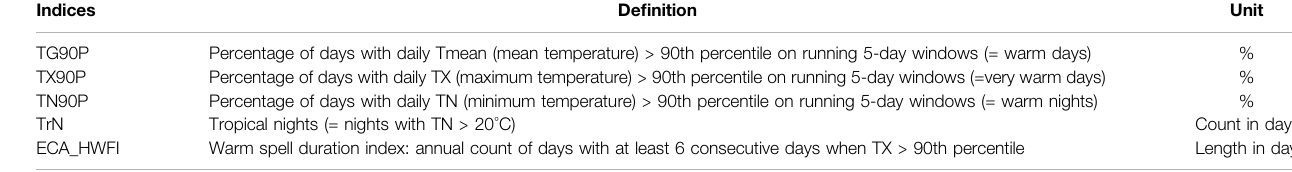
TABLE 1 | De fi nition of climate indices (Peterson et al. 2001).